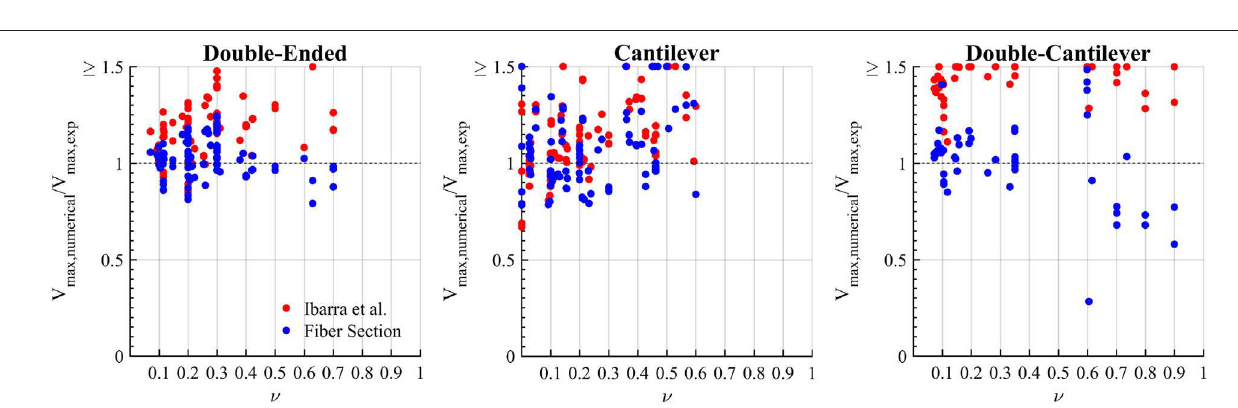
FIGURE 8 | Experimental vs. numerical shear ratios (experimental/numerical) for phenomenological and fiber-section approaches.